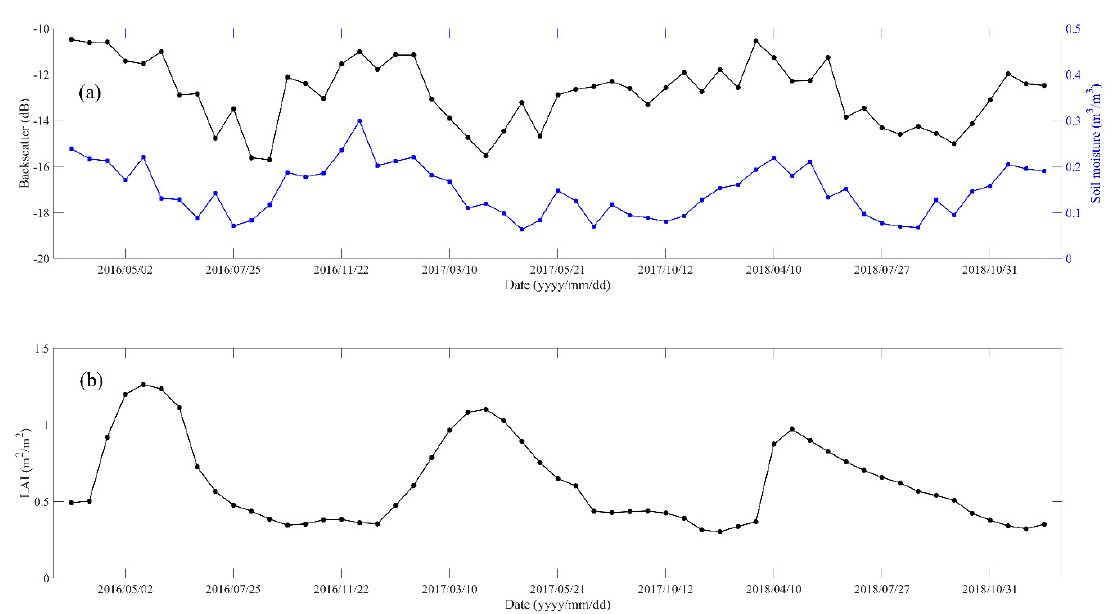
Figure 2. Time series of ( a ) in situ SM (blue line) and Sentinel-1A backscatter (black line) and ( b ) LAI in the Las Bodegas station.